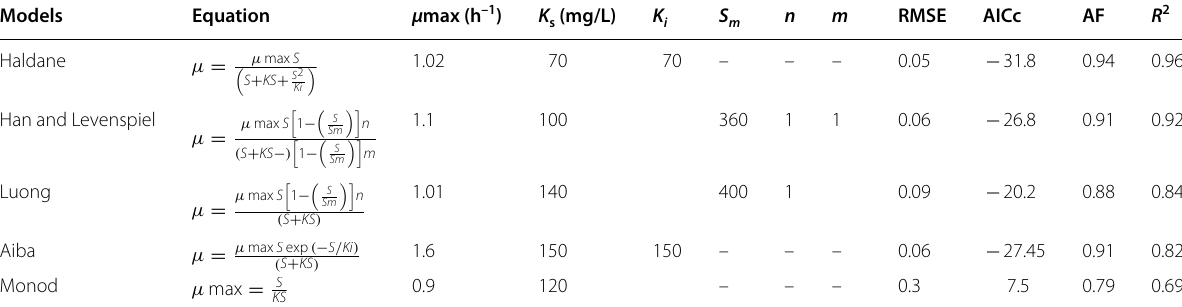
q max : maximal reduction rate (h − 1 ); k s : half saturation constant for maximal reduction (mg/dm 3 ); S m : maximal concentration of substrate tolerated (mg/dm 3 ); m , n , k : curve parameters; S : substrate concentration (mg/dm 3 ); RMS: residual mean square